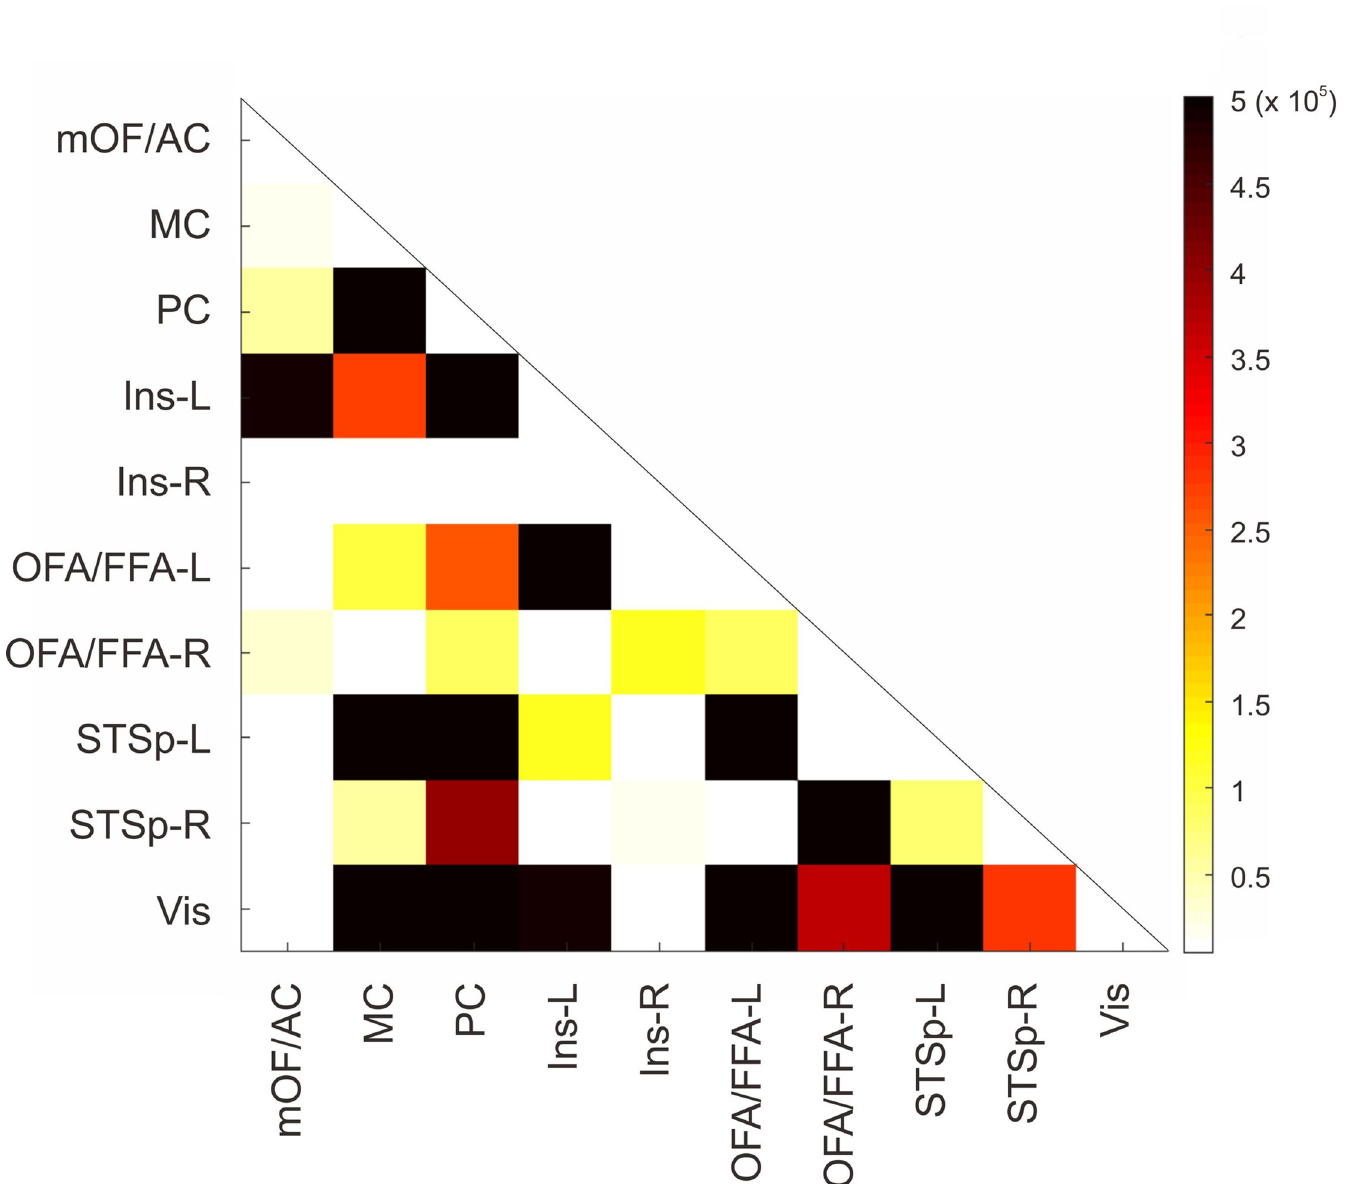
Fig 4. Averaged connectivity matrix across the subjects of cumulated count of visits in each